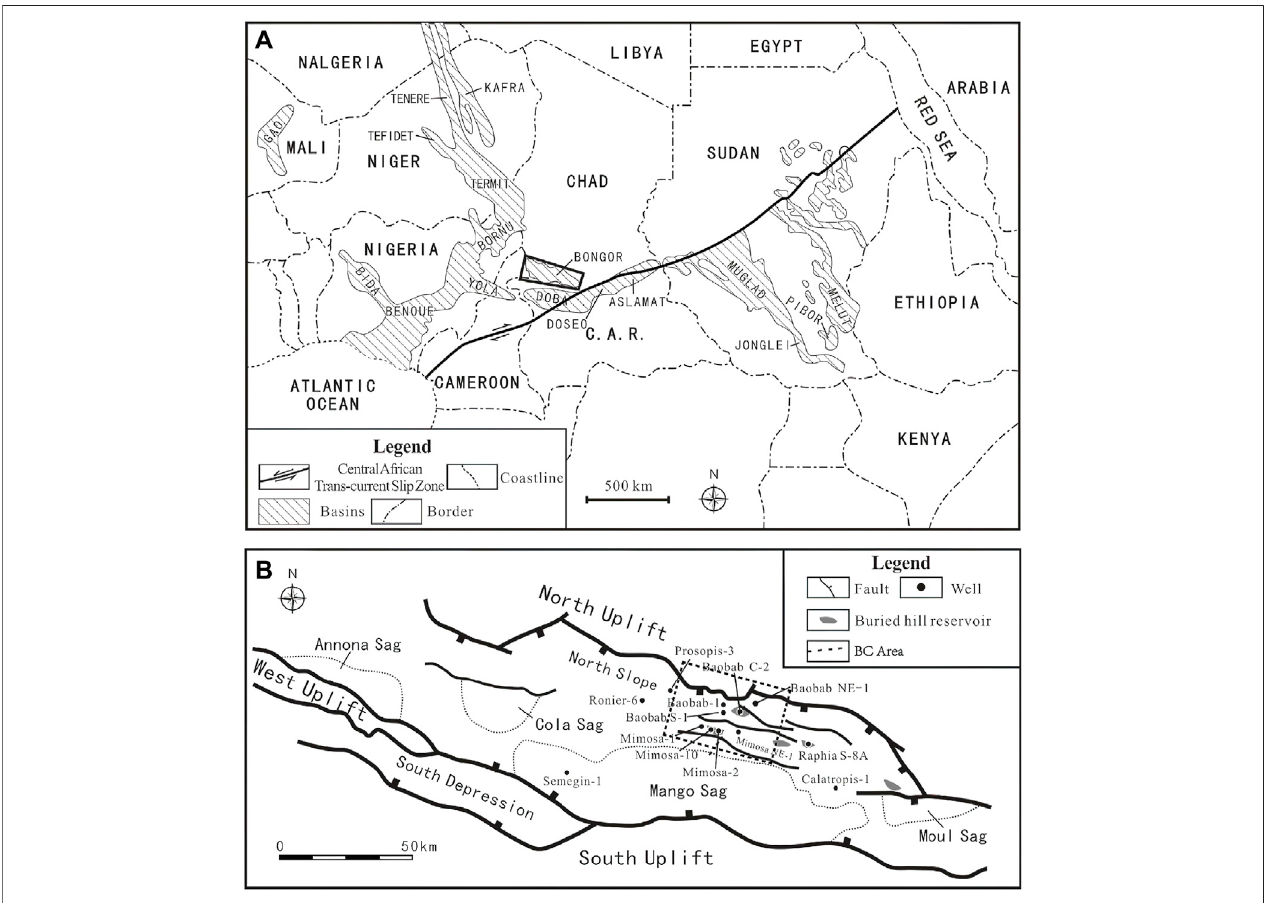
FIGURE 1 | Location map of the study area and study area with main faults. (A) Location of the Bongor Basin and Central African Trans-Current Slip zone and adjacentbasins,suchastheTermit,Muglad,andMelutbasins. (B) Themainfaults,tectonicdivision,andlocationoftheBCblockintheBongorBasinandthediscovered buried-hill hydrocarbon reservoirs with wells (Modi fi ed from Chen et al., 2018).